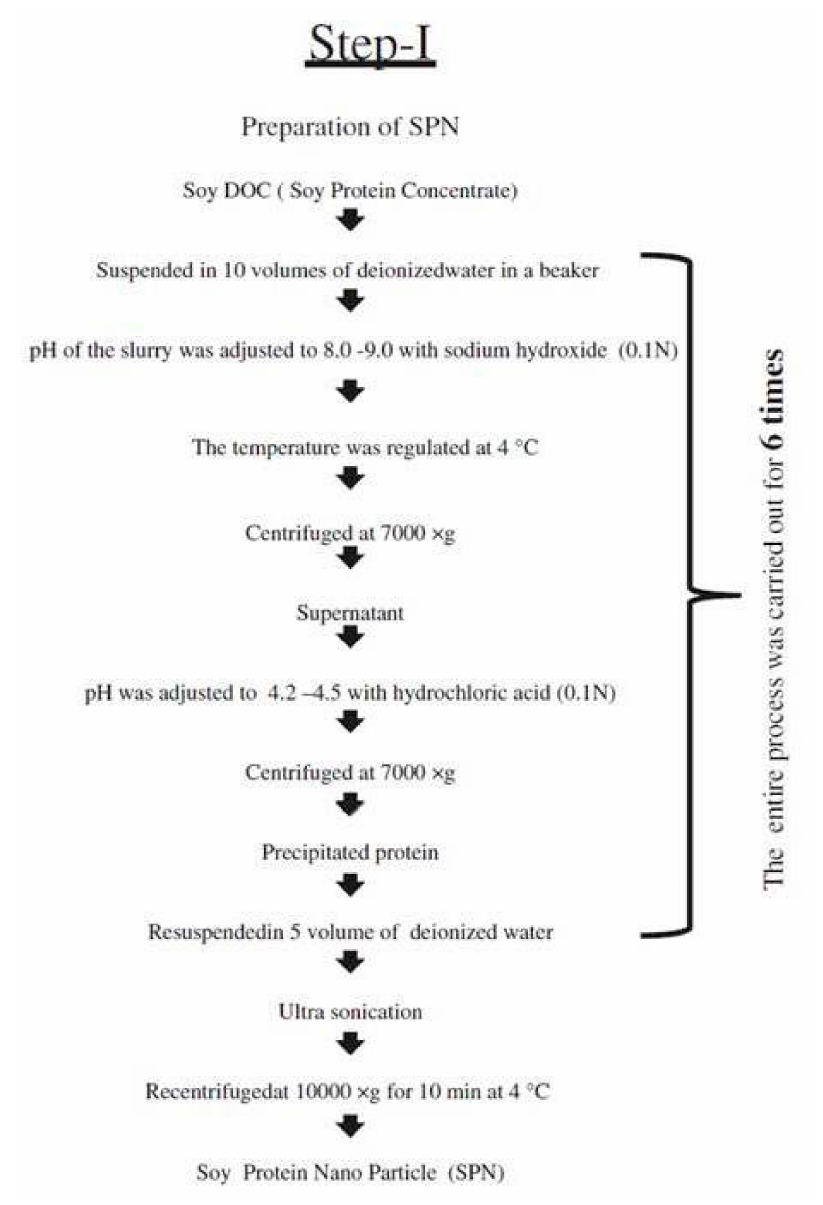
Figure 20. Steps used for the preparation of soy protein nanoparticles to achieve a diameter of 72 nm. Reprinted with permission from ref. [123]. Copyright 2019 John Wiley and